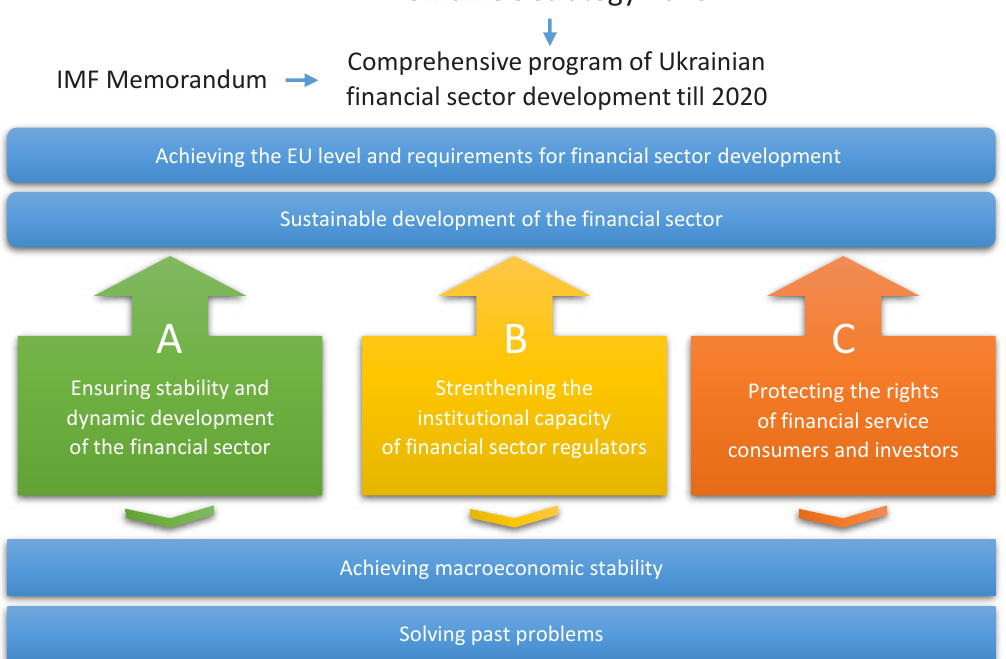
Figure 1. Comprehensive program